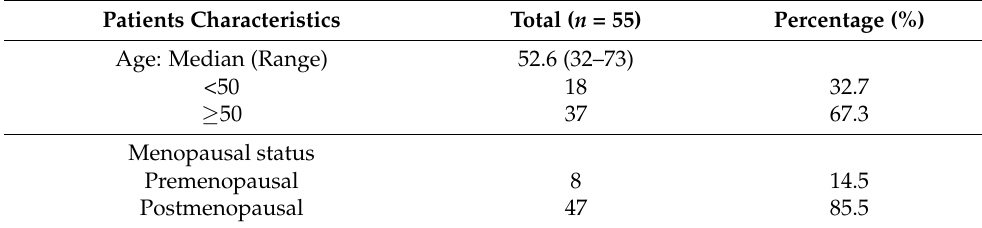
Table 1. Clinicopathological characteristics of the BC